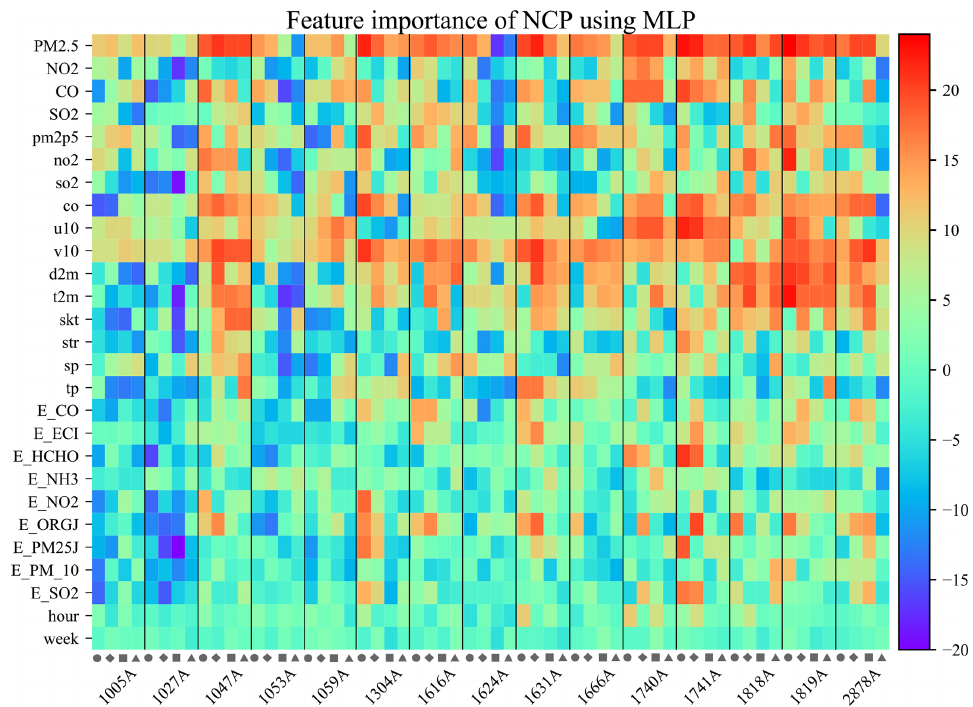
Figure 4. Heatmap of all empirical features with 15 random monitoring stations in NCP and four prediction horizons. The circle, diamond, square, and triangle represent the 6, 12, 18, and 24h prediction horizons, respectively. The heatmap is based on the SAGE analysis ranking of features training by MLP. The warmer the row color, the more significant the corresponding feature. Table 5. Summary of mean and maximum time costs of machine learning model